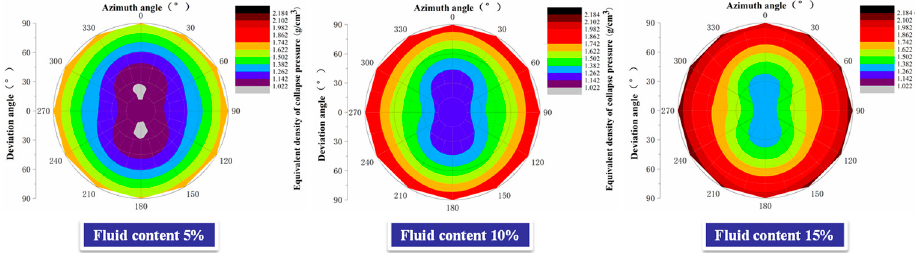
Figure 9. Collapse pressure distribution under different well types and water contents.